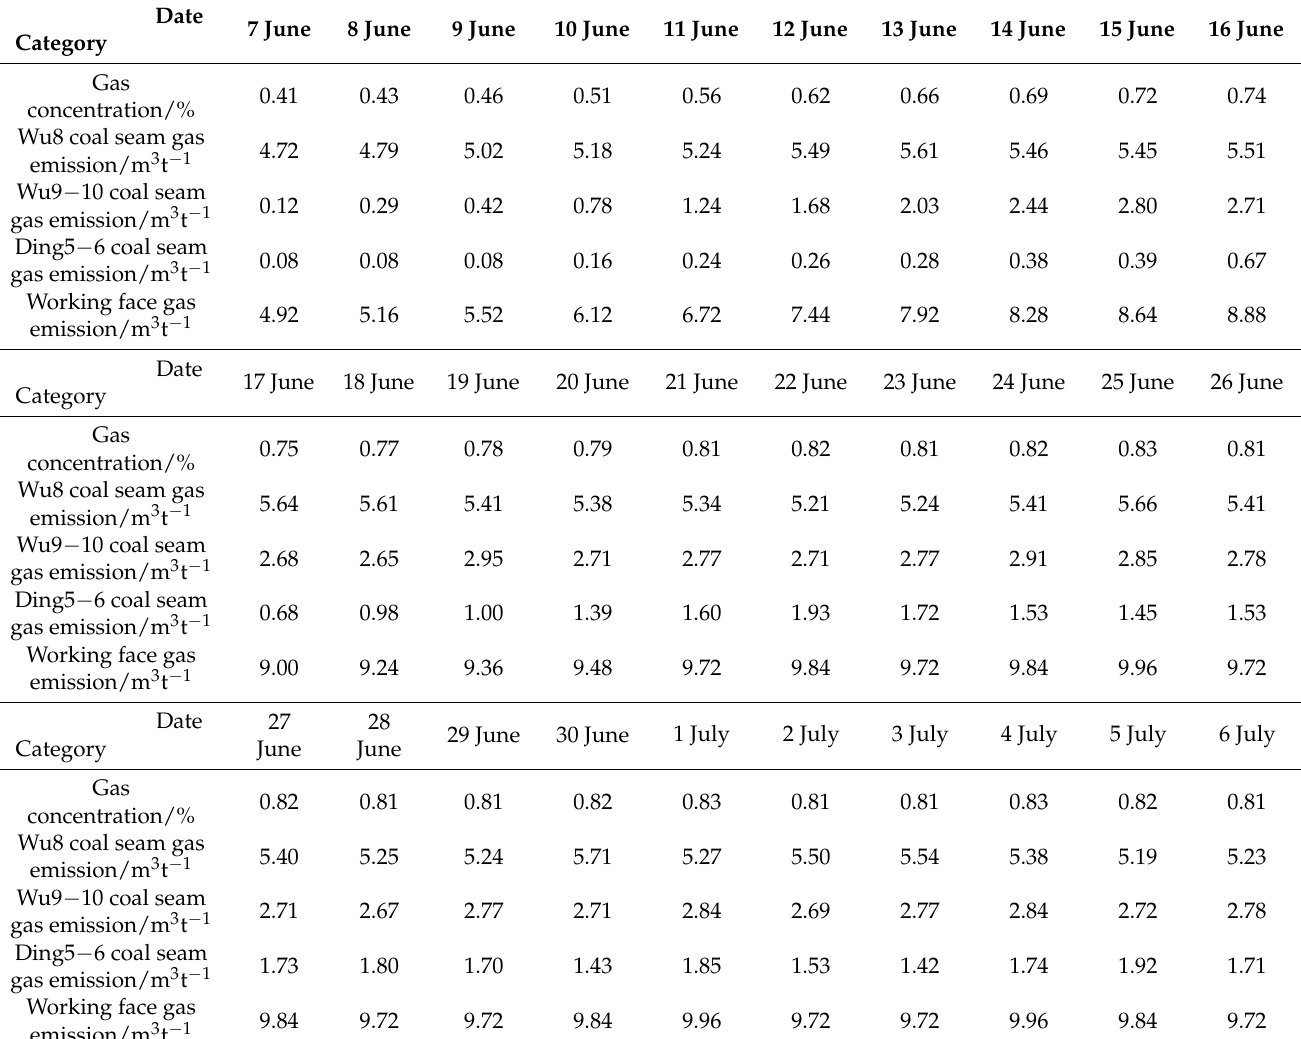
Table 3. Gas emission test results of each coal